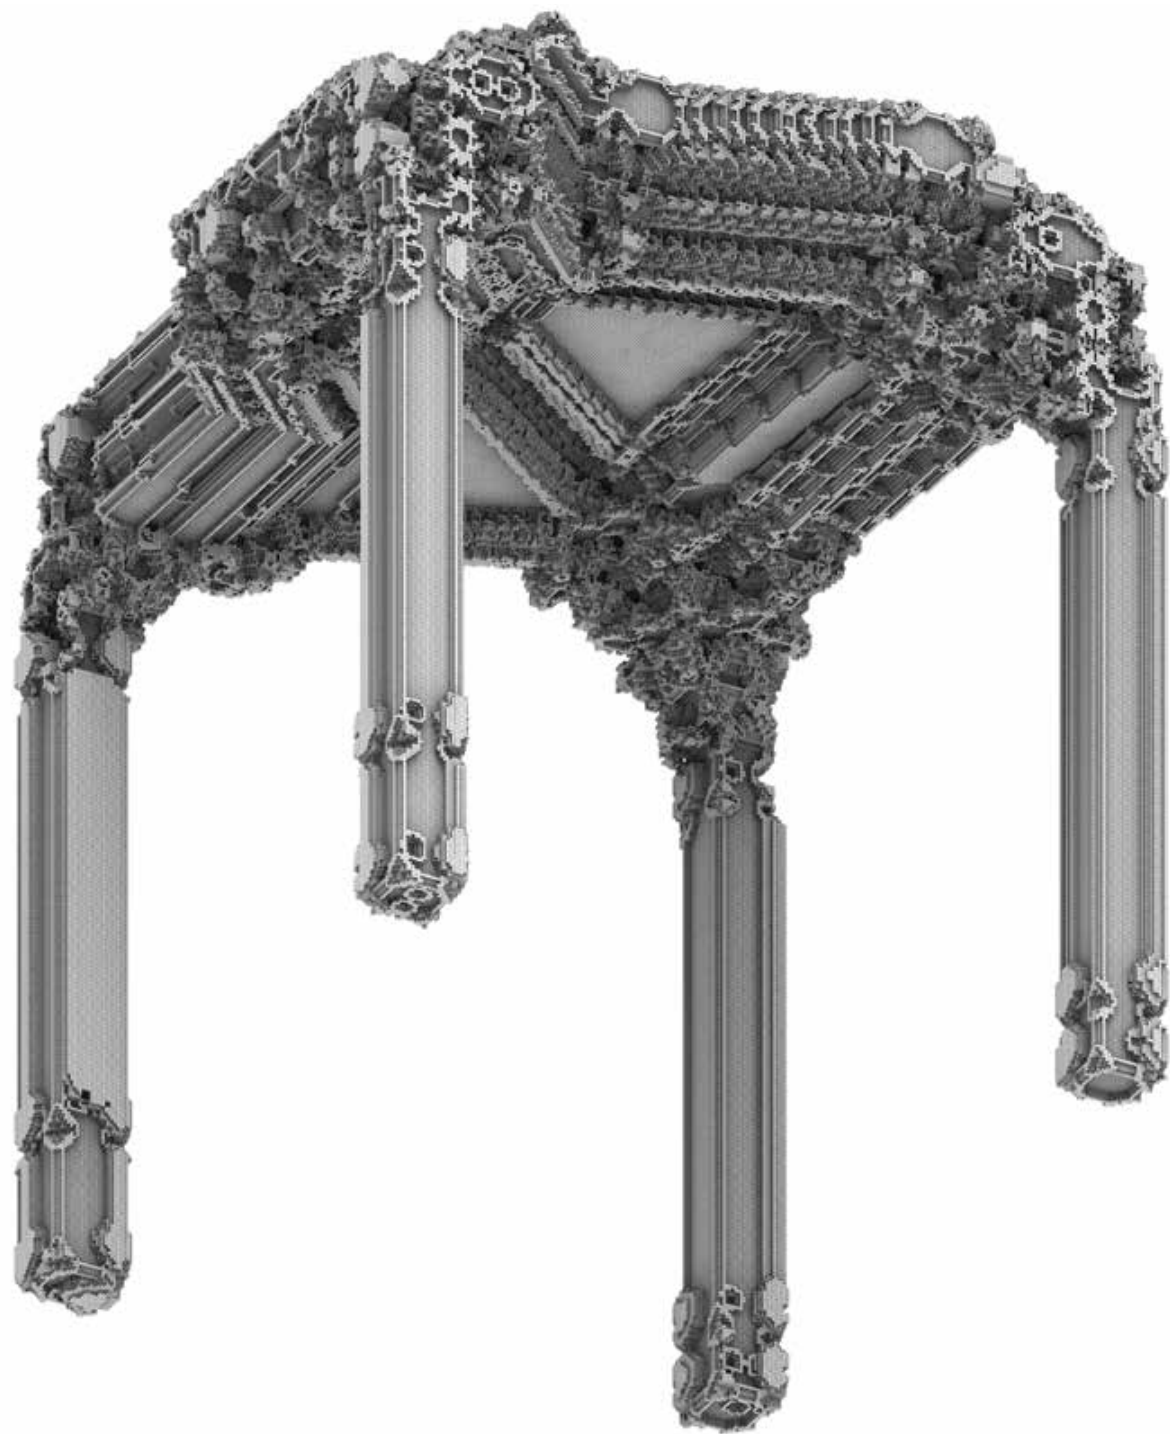
Figure 1—4 (page 81—83): Little Bit Chair (2016), 3D printed Cement. Design: Daniel Widrig